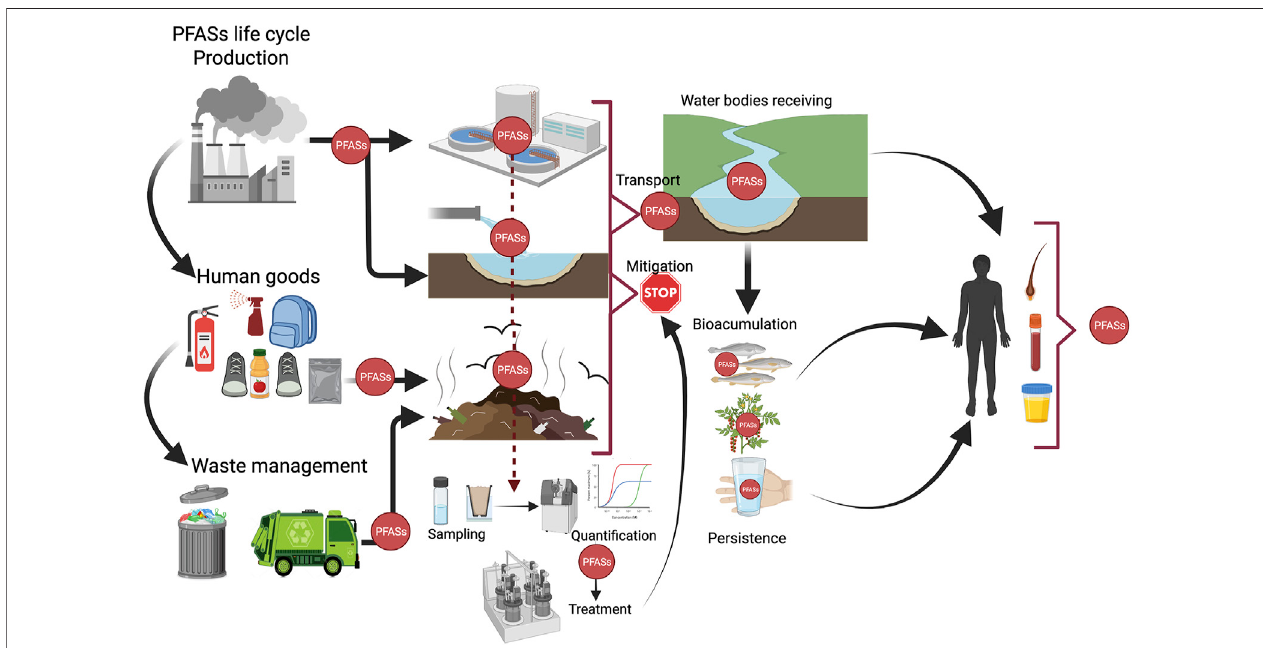
FIGURE 3 | PFAS source, persistence, and transport in the environment to humans, and possible mitigation. Created with BioRender.com.